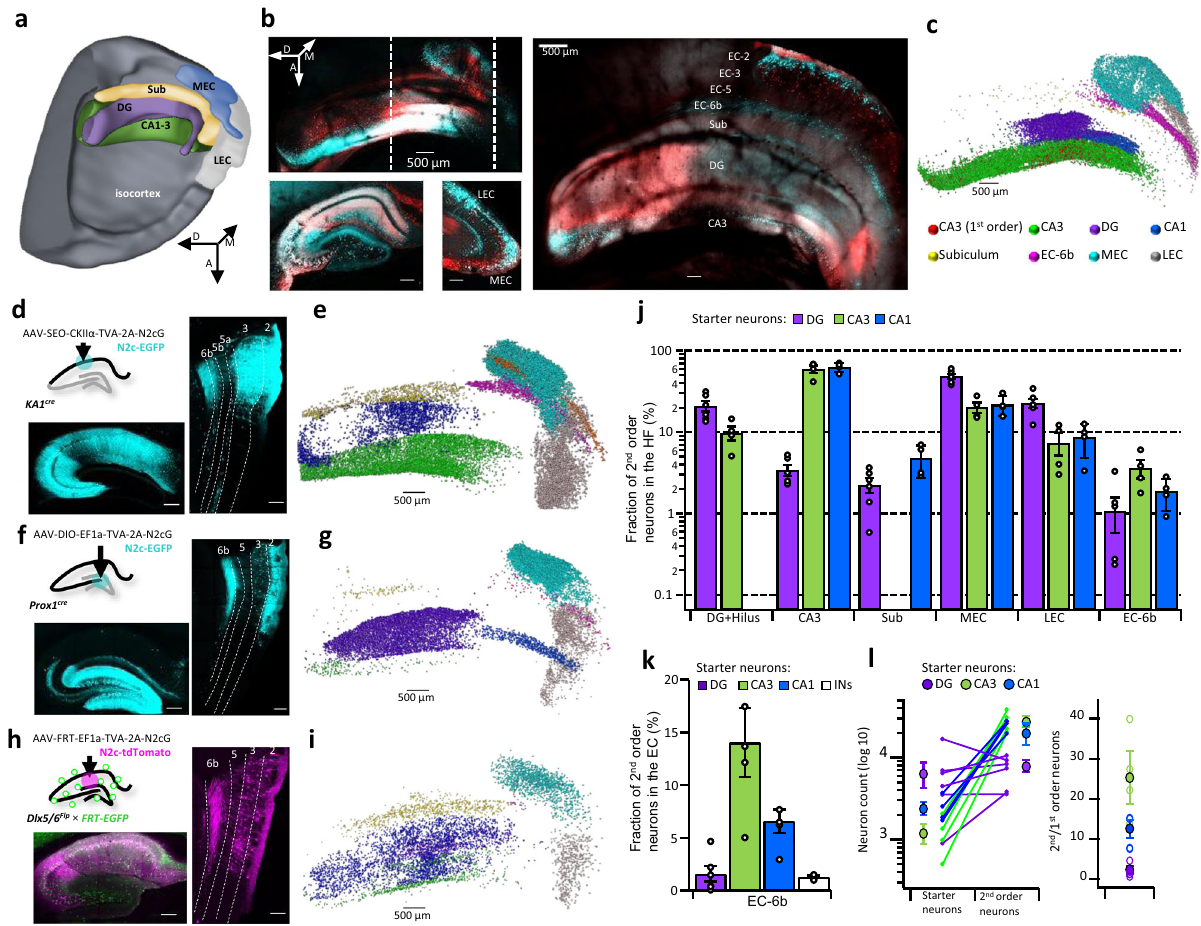
Fig. 2 | EC-6b neurons project to all hippocampal sub-regions with a topo- graphic organization. a 3D schematic overview of the different components comprising the hippocampal formation. A, D, M indicate Anterior, Dorsal, and Medial, respectively. b Intact, cleared cortico-hippocampal preparation following retAAV-assisted labeling from CA3 neurons, as shown in Fig. 1e (red — tdTomato, Cyan — N2c-EGFP; top left), alongside projections of the XY plane along the traced lines(left,bottom)andanannotatedimageofthepreparationintheZplane(right). c Visual representation of the distribution of N2c-EGFP labeled neurons in the EC and HC, following retrograde labeling from the CA3. d , CA1-speci fi c retrograde labeling scheme (top left) and representative confocal images of the HC (bottom left) and EC (right). e Same as c but for retrograde labeling from the CA1. f DGC- speci fi c retrograde labeling scheme (top left) and representative confocal images oftheHC(bottomleft)andEC(right). g Sameas c butforretrogradelabelingfrom the DG. h CA1 IN-speci fi c retrograde labeling scheme (top left) and representative